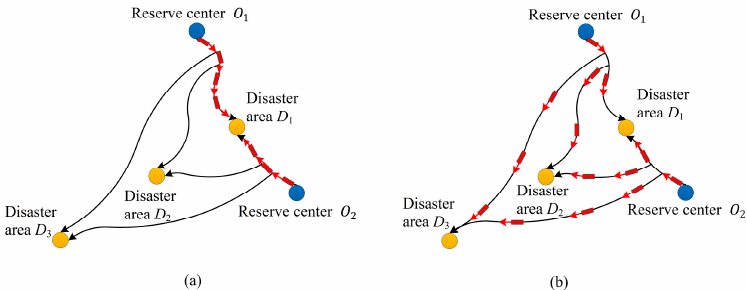
Figure 2. Single VS multiple objectives of vehicle dispatching: ( a ) single-objective; ( b ) multiple objectives.